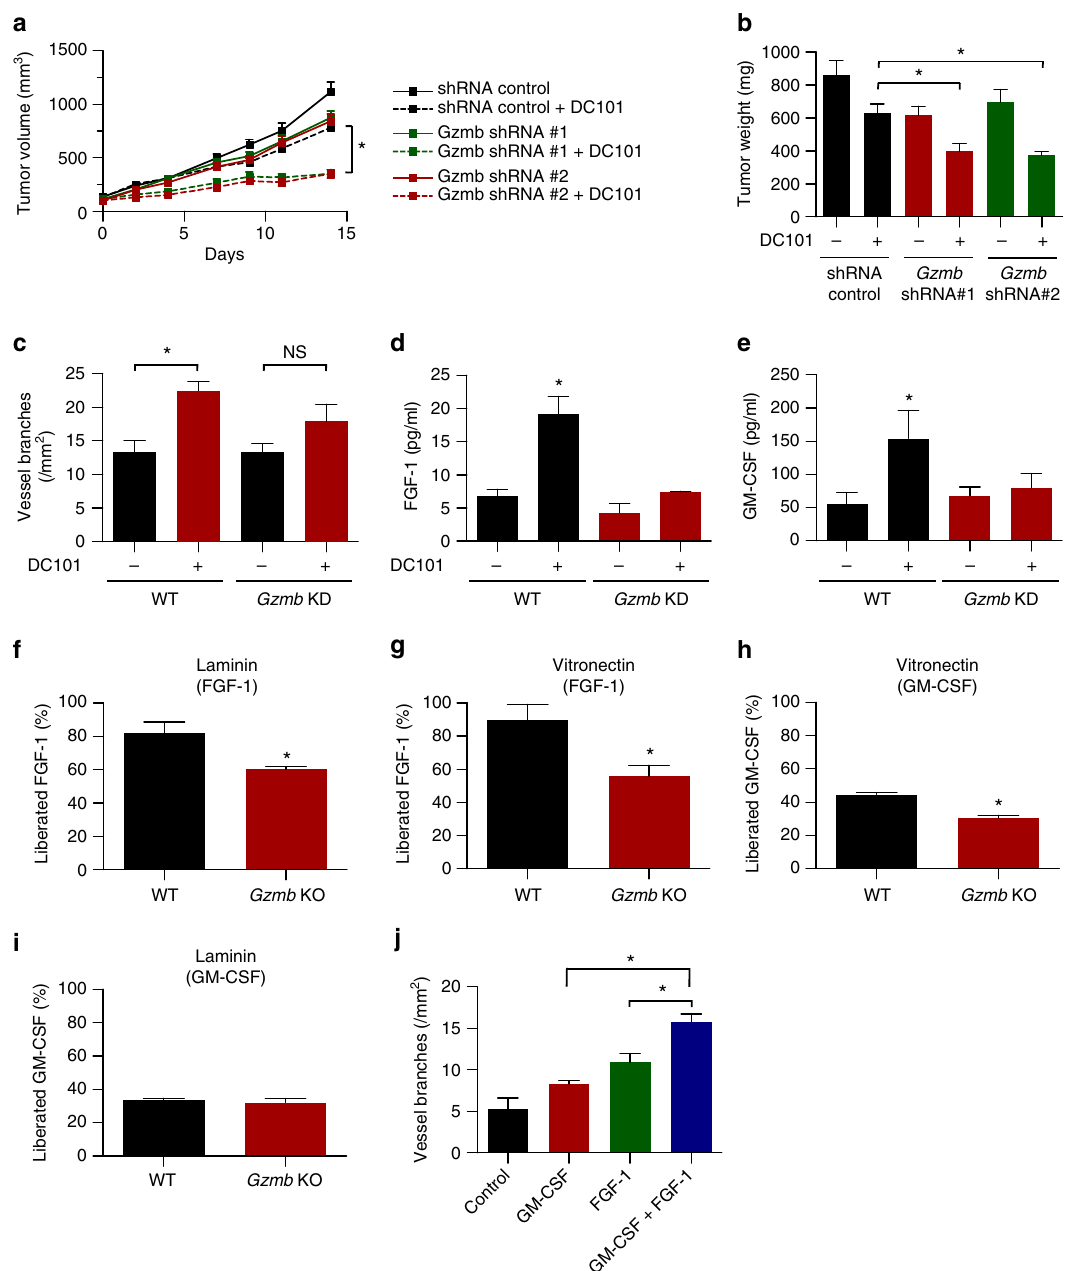
Fig. 4 Mast cell-derived granzyme b confers resistance to AAT by releasing ECM-bound FGF-1 and GM-CSF. a Subcutaneously growing Panc02 tumors shown as tumor volume. Panc02 cells were injected together with WT- or GZMB KD-BMMC into the fl anks of C57Bl/6J (WT) mice. After randomization animals received treatment with placebo or 20mg/kg DC101 ( n = 8/8/8/6; * p < 0.05; two-way ANOVA). b Weight of end-stage Panc02 tumors at day of euthanasia ( n = 8/8/5/5; * p < 0.05; one-way ANOVA). c Tube formation assays of HUVEC in the presence of tumor-conditioned media from tumors transplanted together with WT and GZMB KD-BMMC and treated with placebo or 20mg/kg DC101 ( n = 8/8/8/6; * p < 0.05; one-way ANOVA). d , e ELISAs showing upregulation of free FGF-1 ( d ) or free GM-CSF ( e ) in tumor-conditioned media ( n = 3 – 6; * p < 0.05; one-way ANOVA). f – i Mobilization of FGF-1 ( f , g ) or GM-CSF ( h , i ) from a laminin or vitronectin matrix using conditioned media from WT or Gzmb KO-BMMC ( n = 3; * p < 0.05; two-tailed t -test. j Tube formation assays of HUVEC using 5ng/ml GM-CSF or FGF-1 ( n = 3 – 4; * p < 0.05; one-way ANOVA). Results are shown as representative means ±